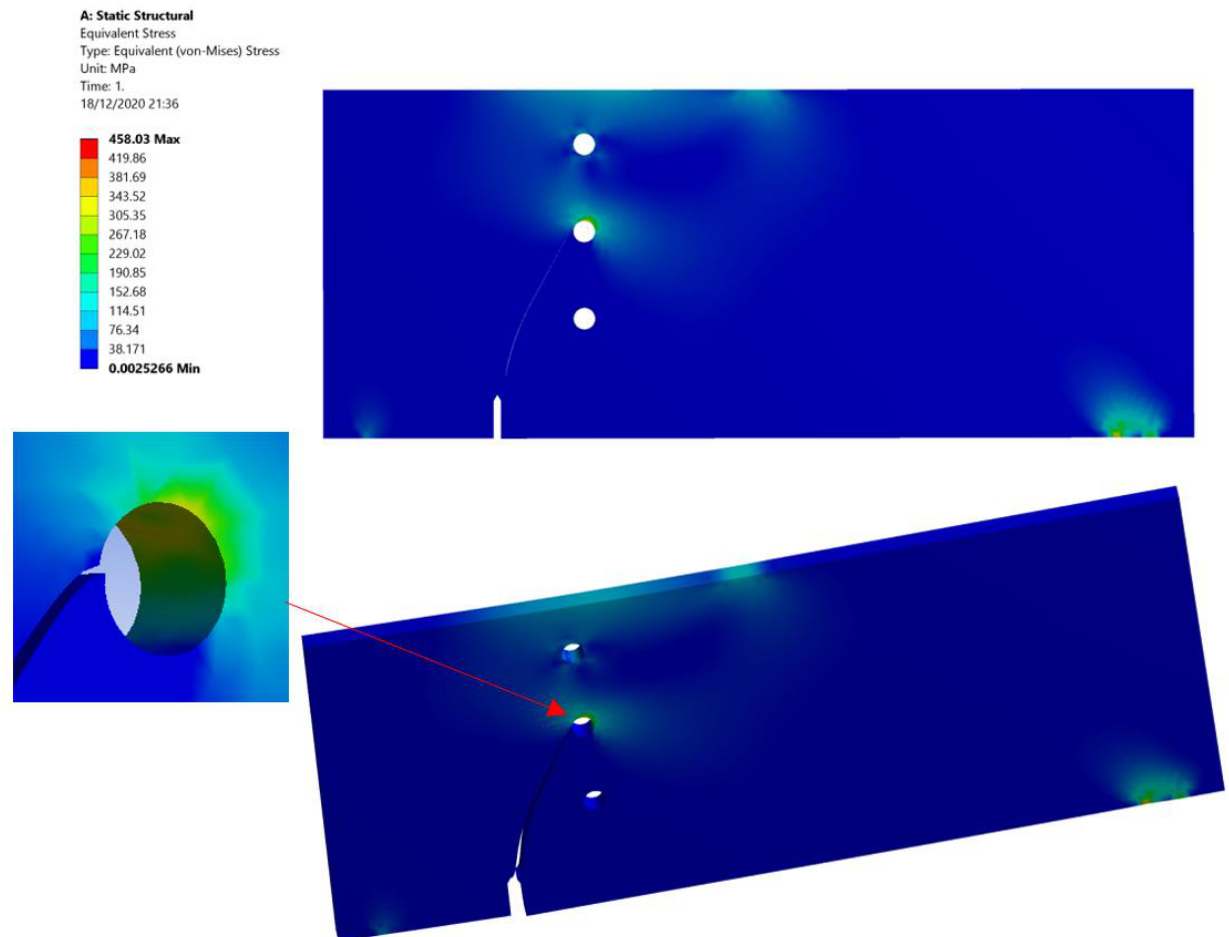
Figure 11. Comparison for the dimensionless SIFs for specimen 3.